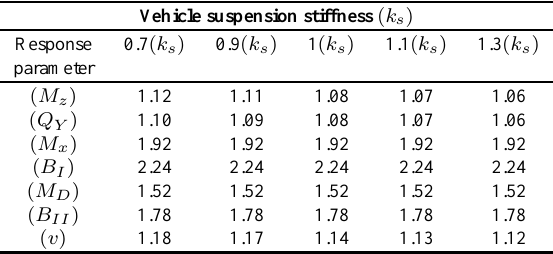
Table 11 Effect of vehicle suspension stiffness ( k s ) on impact